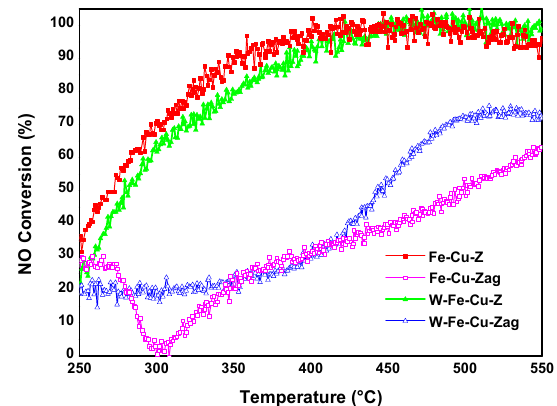
Figure 10. NO conversion over fresh and aged catalysts.